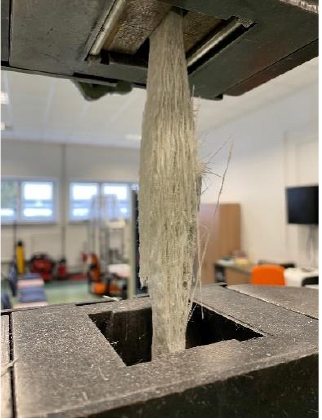
Figure 1. The specimen after failure—tensile test. Table 1. Results of tensile tests (mean values and standard